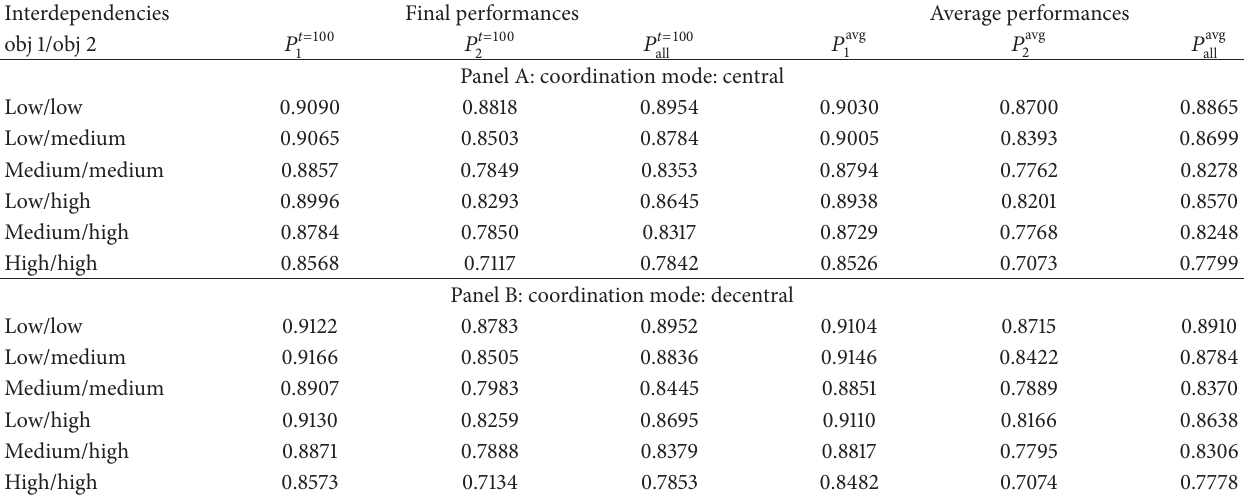
Table 2: Satisficing approach, aspiration level for objective 1: 𝑠 1 = 0.8 .